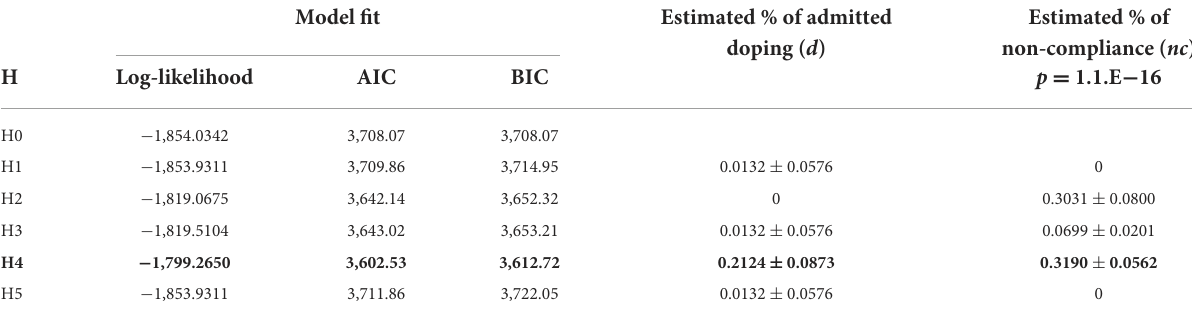
TABLE 4 Estimated use of prohibited performance enhancing substances and/or methods at WCA (12-month